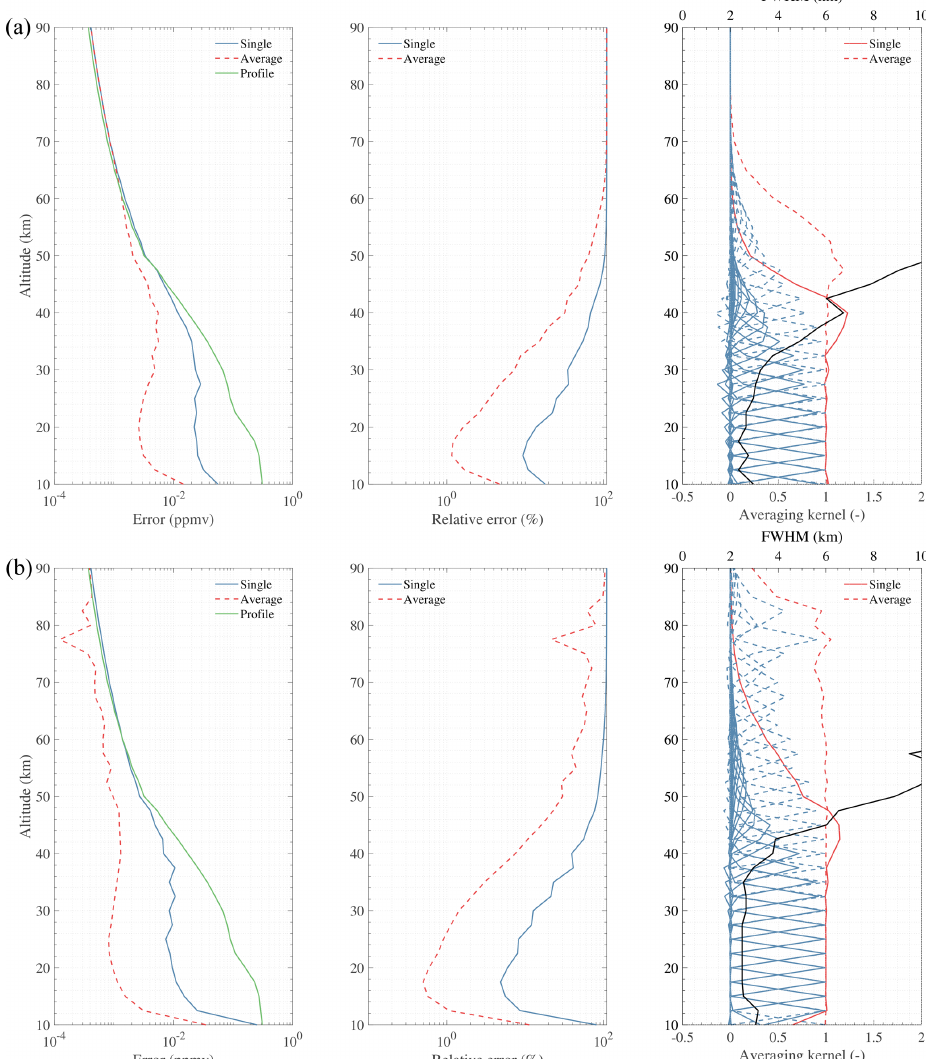
Figure 17. Simulation results of N 2 O retrieval using 200.98 (a) and 652.834GHz (b) lines. “Single” and “Average” represent the retrieval error using different noise. “Profile” represents the typical profile used in the simulation. The black solid line in the last panel represents the FWHM (i.e. vertical